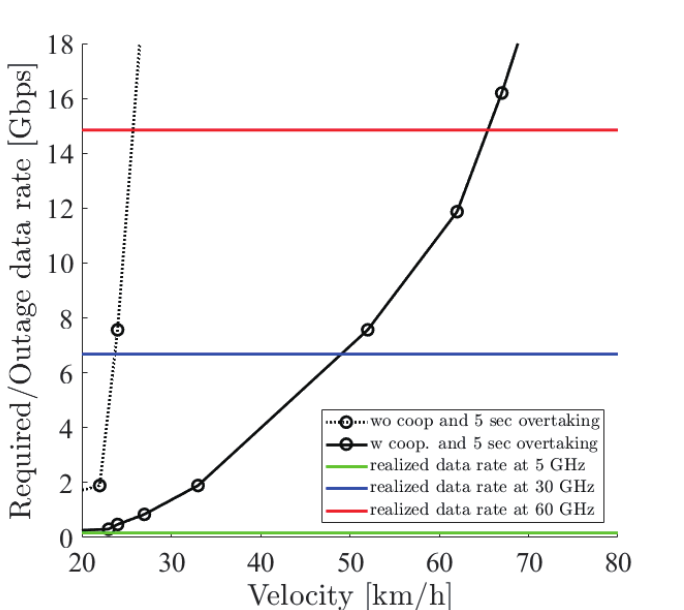
Figure 19. Required data rate and 0.01% outage data rate realized by the 5, 30 and 60 GHz bands under d be = 10